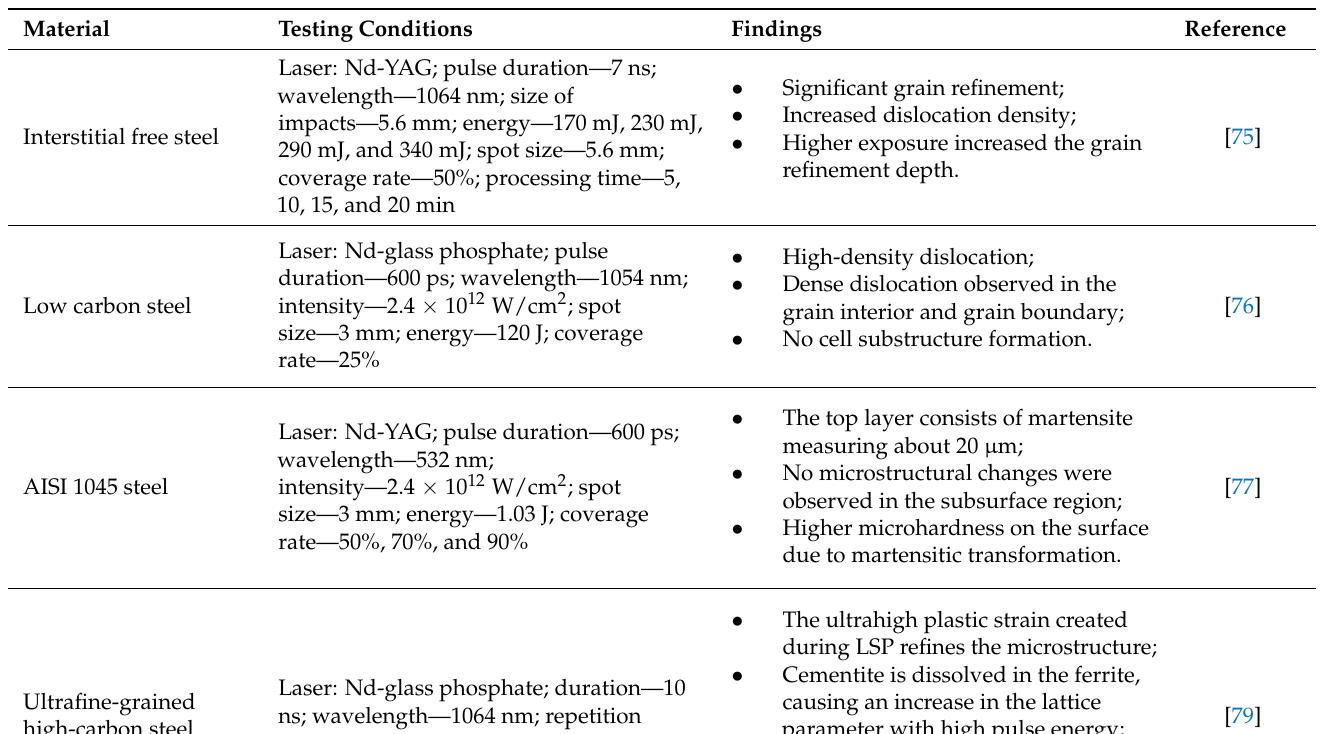
Table 1. Effect of LSP on microstructural